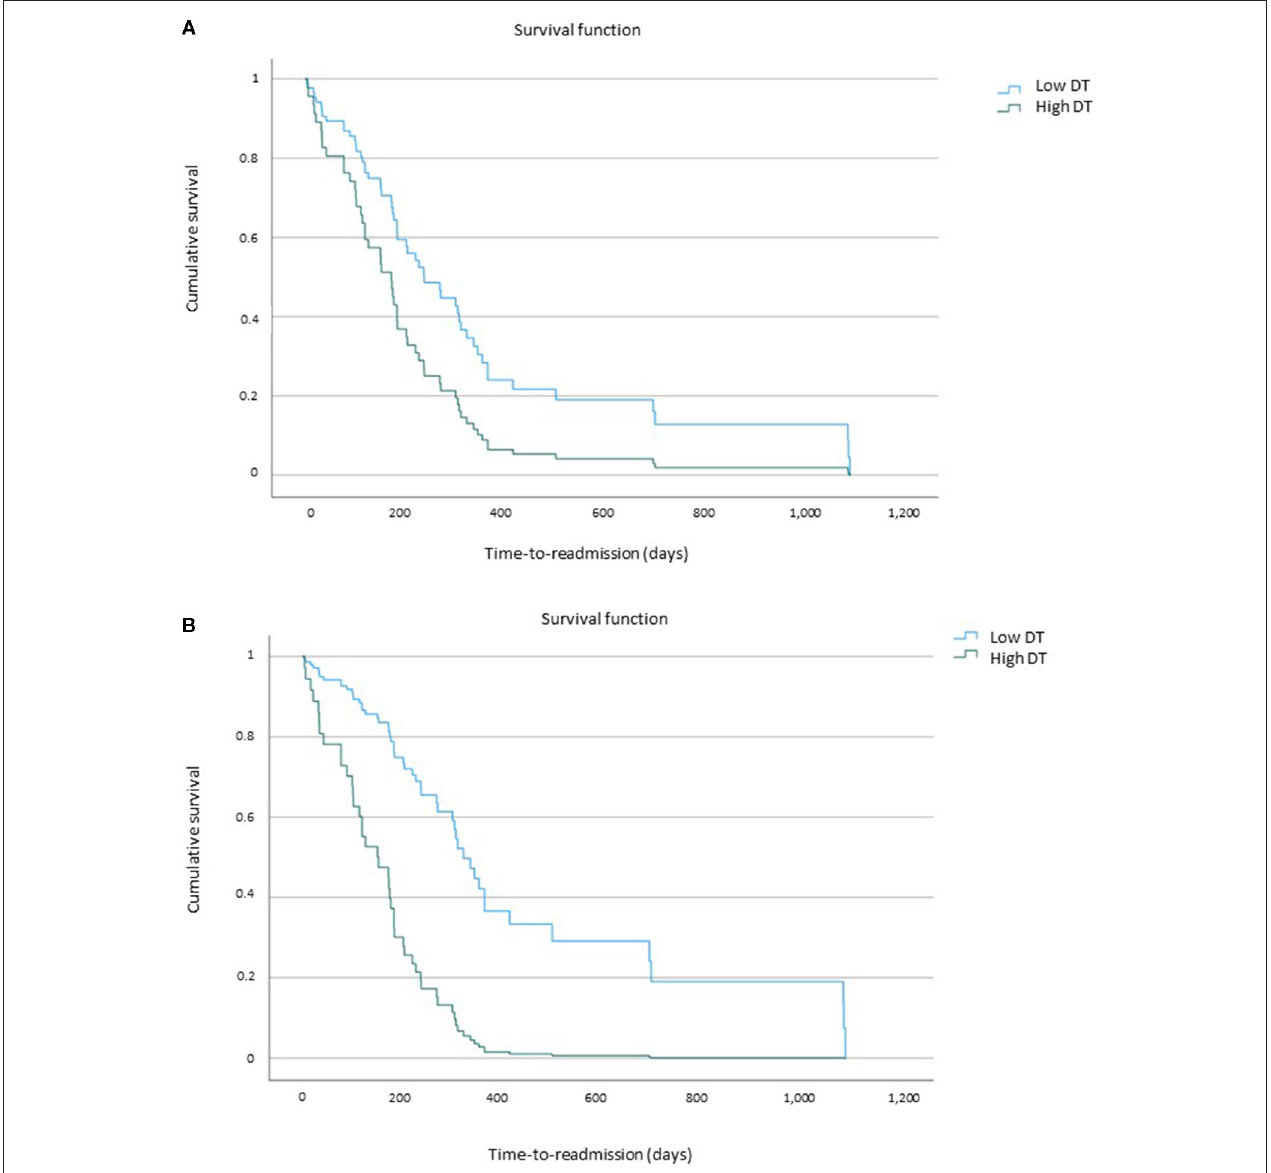
FIGURE 2 | High drive for thinness (DT) as a predictor of shorter time-to-readmission. (A) Uncorrected model of high drive for thinness (DT) as a predictor of time-to-readmission. (B) Corrected model (statistical control for age, duration of illness, EDI–2 bulimia and body dissatisfaction, STAl-S, BDl, and BSQ) of high drive for thinness as a predictor of